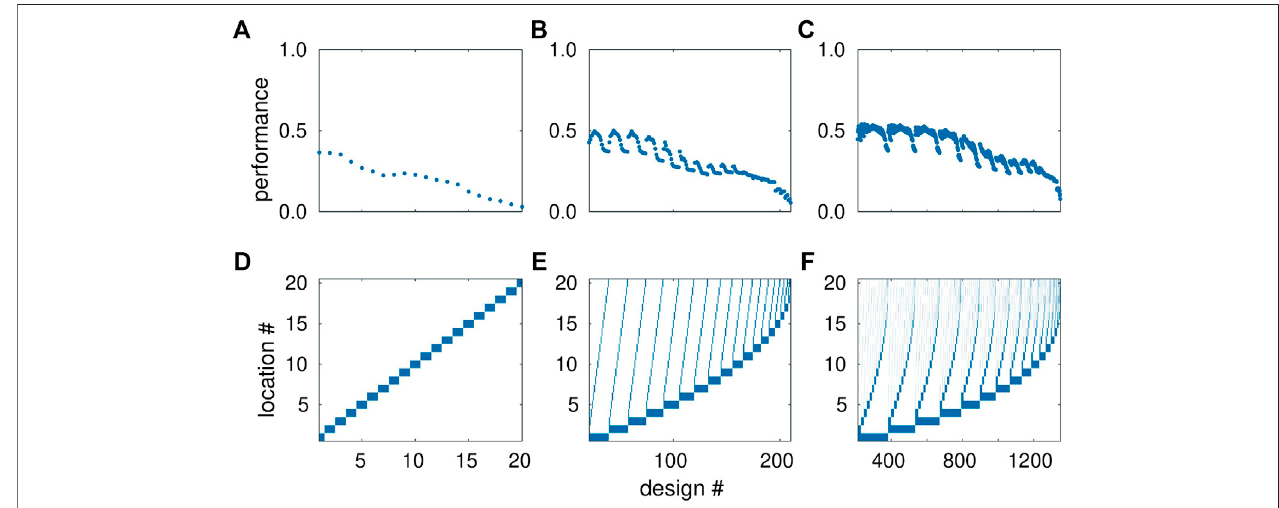
FIGURE 8 | Performance of all 1,350 investigated monitoring designs. Top row (A – C) : normalized utility function ϕ ( d ) of the given design according to Eq. 26 ; bottom row ( D – F ): piezometer combination of the given design. (A , D) Designs with one additional piezometer; (B , D) with two additional piezometers; (C , F) : with three additional